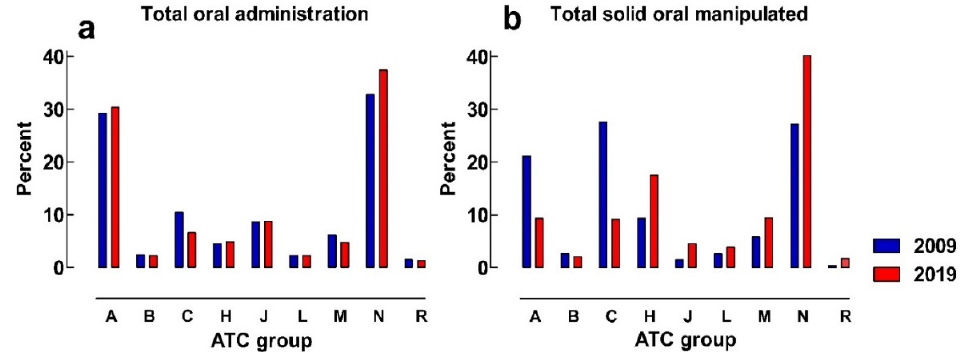
Figure 2. ( a ) Percentage of the distribution of total oral administrations between ATC-groups at inpatient units; ( b ) percentage of the distribution of solid oral manipulations between different ATC-groups at inpatient units. A = alimentary tract, B = blood and blood forming organs, C = cardiovascular system, H = systemic hormonal preparations, J = anti-infectives for systemic use, L = antineoplastic and immunomodulating agents, M = musculoskeletal system, N = nervous system, R = respiratory system.